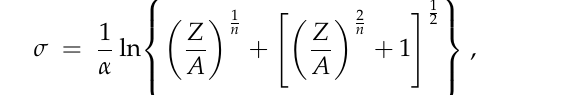
Figure 1. The linear fit results of ( a ) ln 𝜀(cid:4662) -ln σ ; ( b ) ln 𝜀(cid:4662) - σ ; ( c ) ln 𝜀(cid:4662) -ln[sinh( ασ )] and ( d ) ln[sinh( ασ )]-1000/ T .